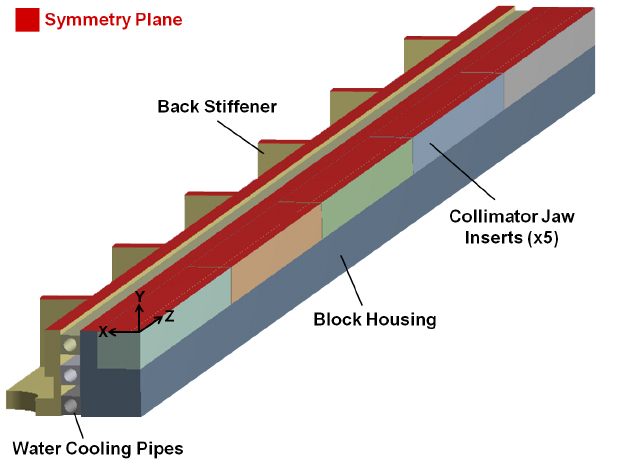
FIG. 8. The lower symmetrical half of a horizontal TCT jaw structure. The symmetry plane ( x - z plane) is shown in red.